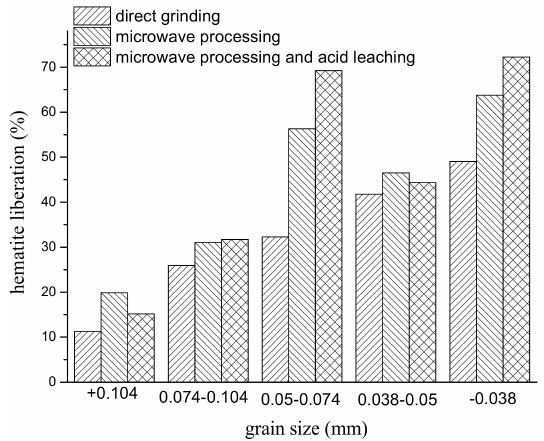
Figure 12. Hematite liberation of three respective samples grinding products with different grain size ranges.